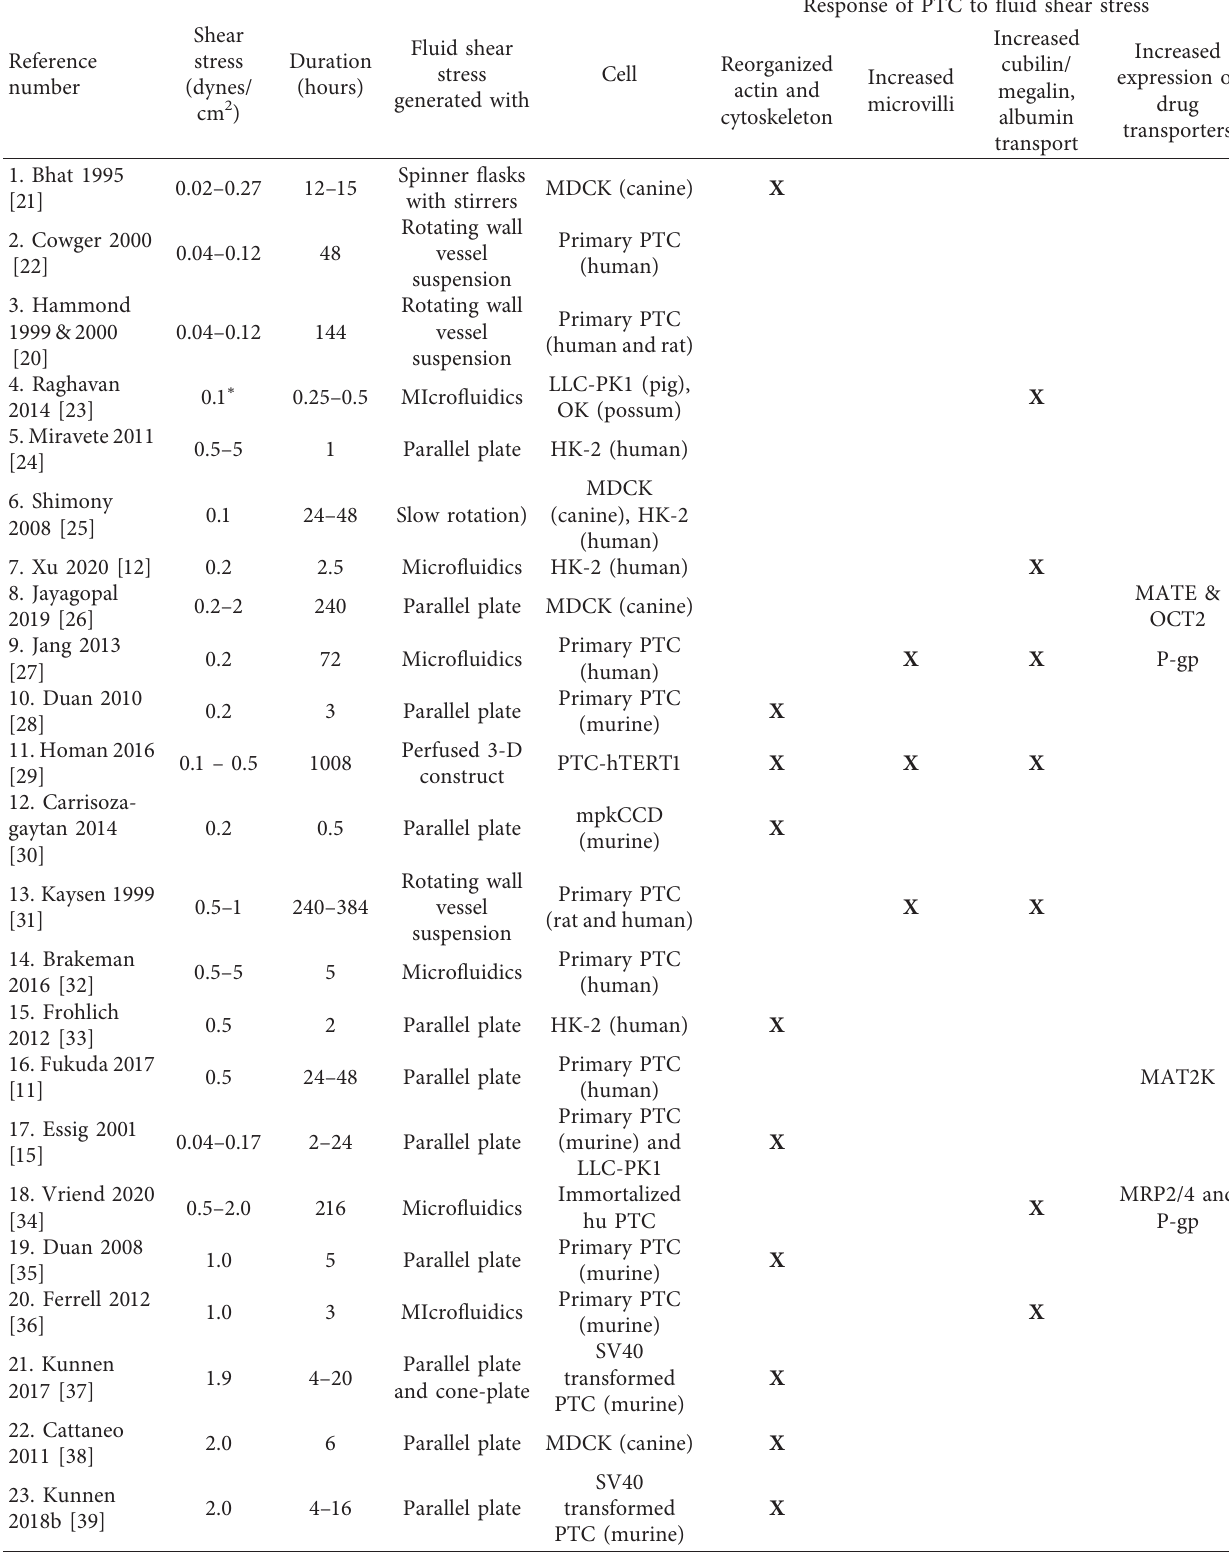
Table 1: The study reference, shear stress in dynes/cm 2 , duration in hours, technology utilized, and cell